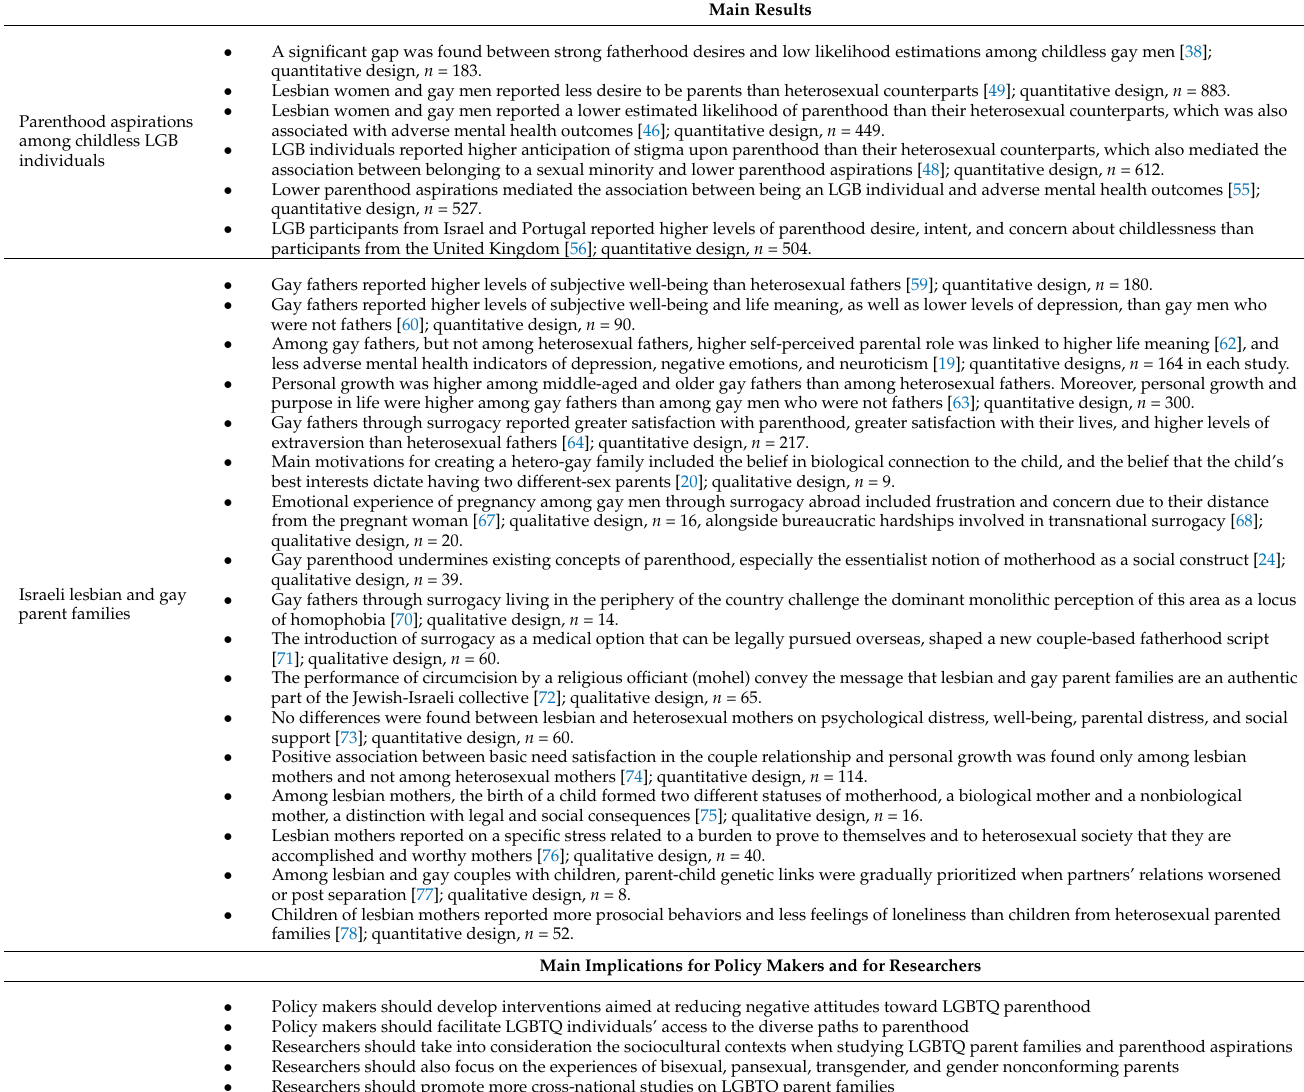
Table 1. Summary table of the main results and implications of the review of research on LGBTQ parent families in